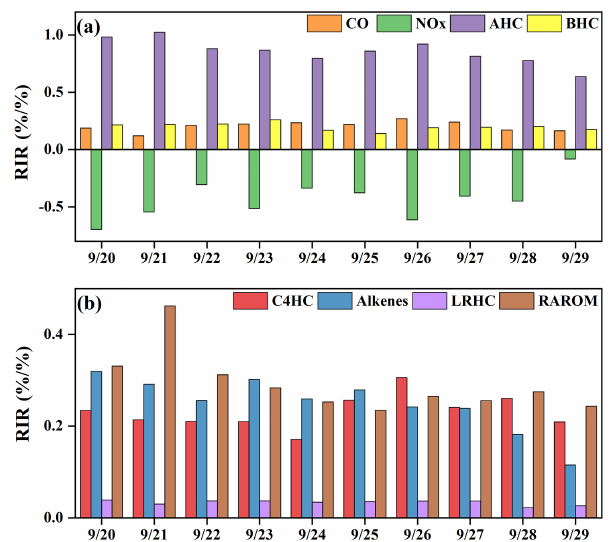
Figure 9. The model-calculated RIRs for (a) major O 3 precur- sor groups and (b) the AHC sub-groups during high-O 3 daytime (06:00–18:00LT) (AHCs: anthropogenic hydrocarbons; BHCs: bio- genic hydrocarbons; RAROM: reactive aromatics except for ben- zene; LRHCs: low-reactivity hydrocarbons; C4HC: alkanes with ≥ 4 carbons; and